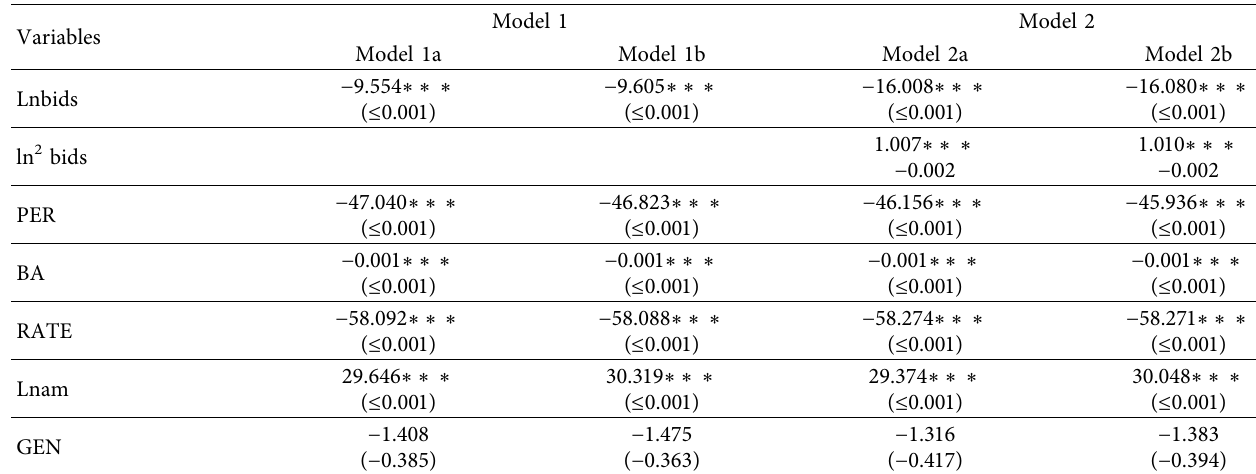
Table 9: Expanding the bids occurred at